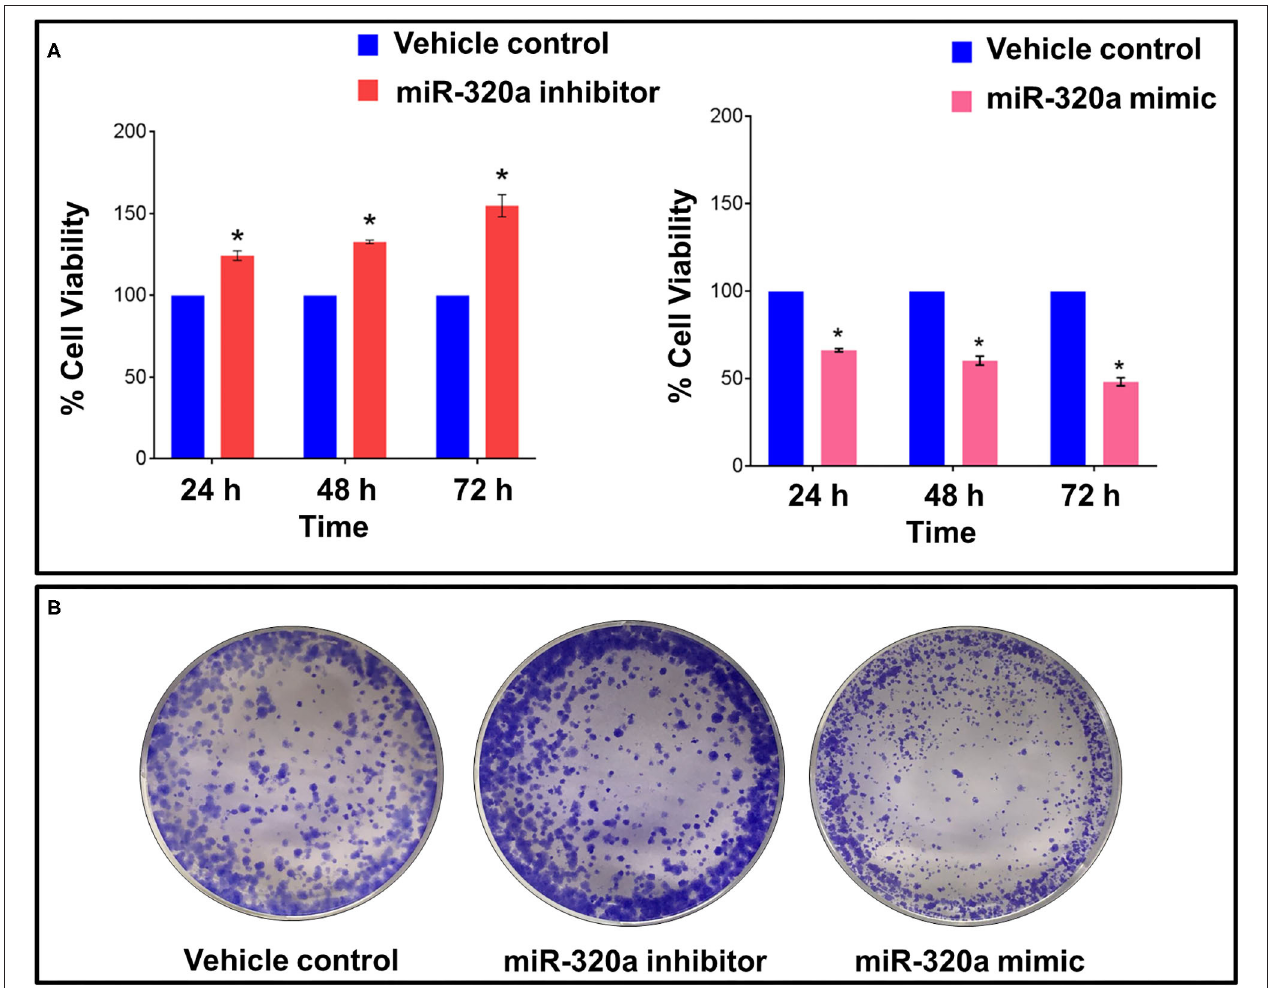
FIGURE 3 | Impact of miR-320a on cell proliferation in A549 cells. A549 cells were transfected with a miR-320a inhibitor (100 nM) or mimic (100nM) and compared to the vehicle control, as assessed by: (A) MTT assays at 24, 48, and 72h post transfection, expressed as mean ± SEM; and (B) representative image of colony forming assays. * p <